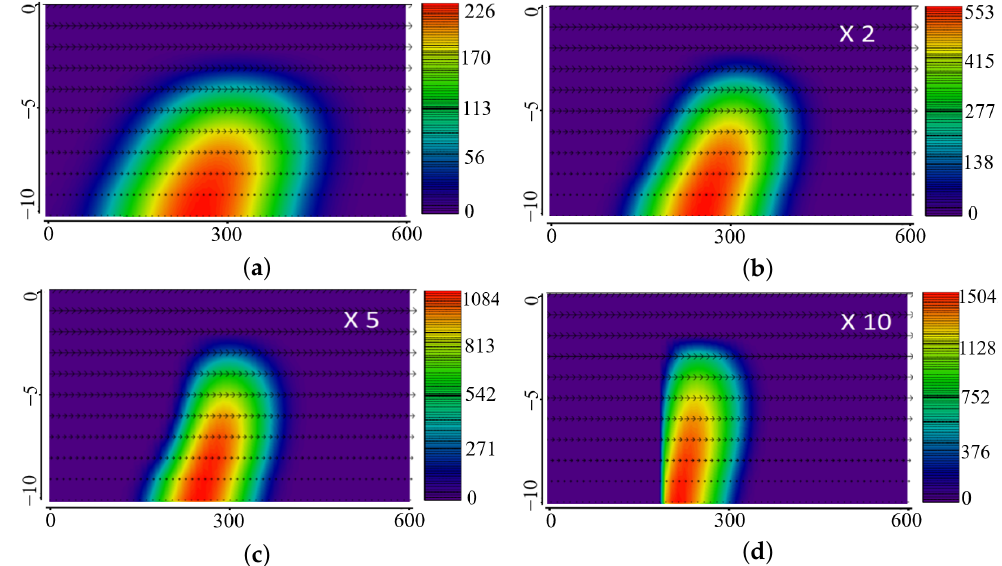
Figure 7. Modeling the propagation of suspended particles during soil dumping at different water flow velocities and different time intervals: ( a ) time interval is 30 min and initial velocity; ( b ) time interval is 15 min and velocity increased by 2 times; ( c ) time interval is 6 min and velocity increased by 5 times; ( d ) time interval is 3 min and velocity increased by 10